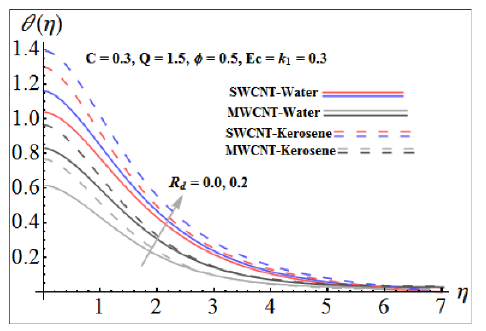
Figure 7. Behavior of θ ( η ) for increased values of Q .